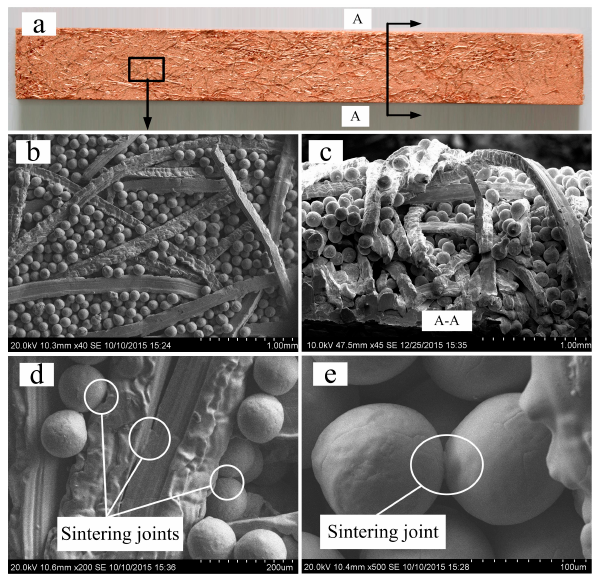
Figure 1. Characteristics of the PMFPSCS: ( a ) appearance of PMFPSCS; ( b ) SEM image of PMFPSCS; ( c ) cross section of PMFPSCS; and ( d , e ) sintering joints of PMFPSCS.